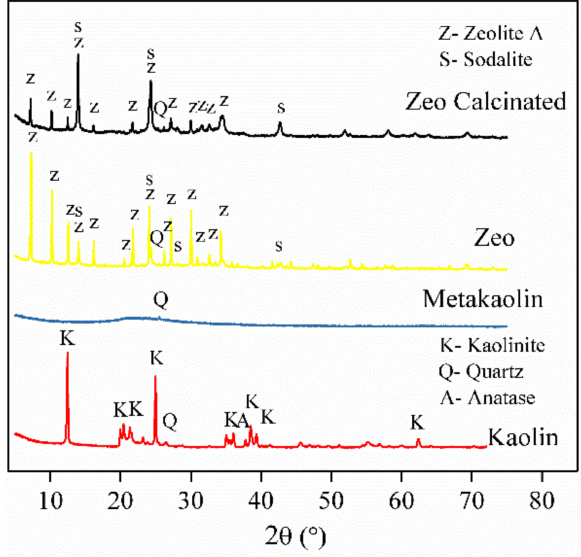
Figure 1. XRD patterns of the zeolite synthesis process. X-ray diffraction patterns of catalysts are shown in Figure 2. For the NiZeo catalyst, diffraction peaks at 37.48 ◦ , 43.54 ◦ , and 62.84 ◦ 2 θ were attributed to the cubic structure of NiO (ICOD 01-073-1523) [3,30]. In this spectrum it was also observed that the incorporation of nickel did not seem to destroy the structure of zeolitic material [31].